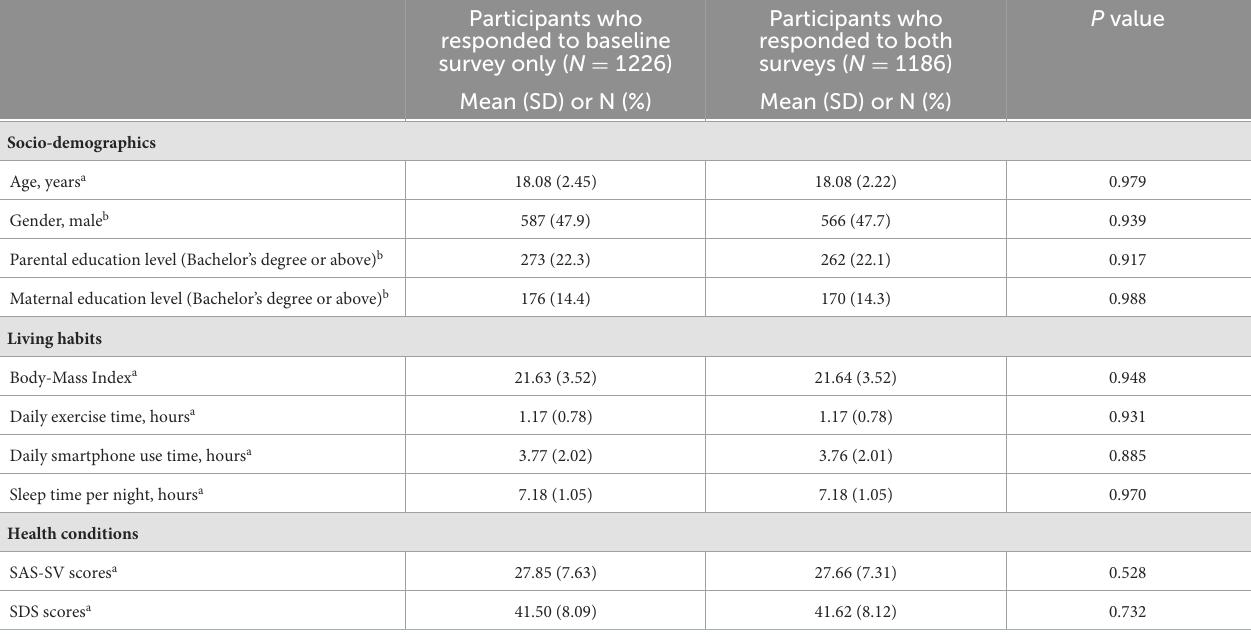
TABLE 1 Descriptive characteristics comparing groups responding at baseline only, or both